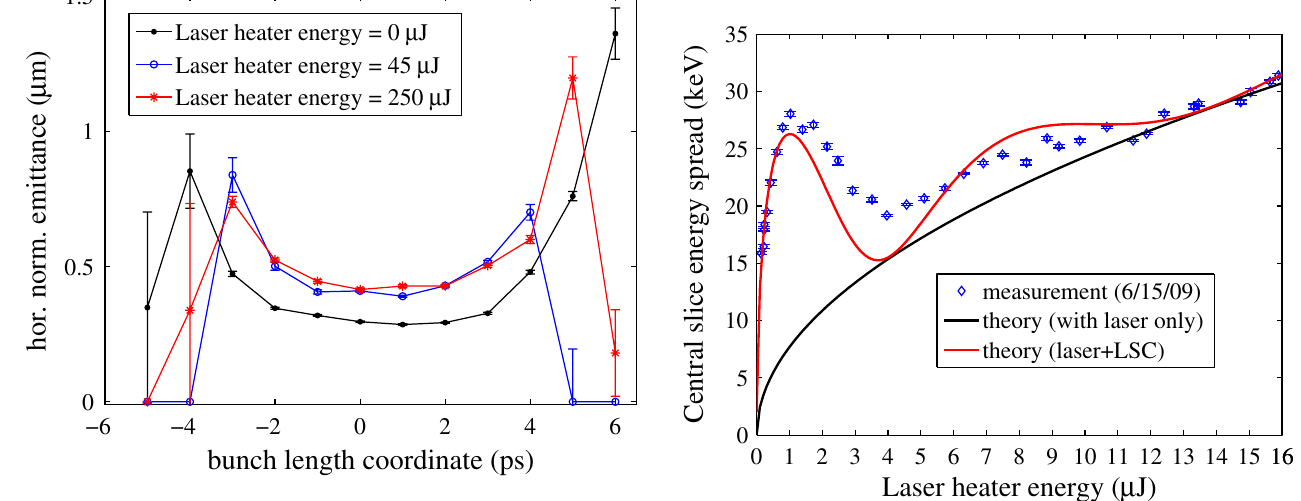
FIG. 10. (Color) Measured horizontal slice emittance at 250 pC bunch charge on OTR2 vs bunch coordinate for different laser- heater energies.